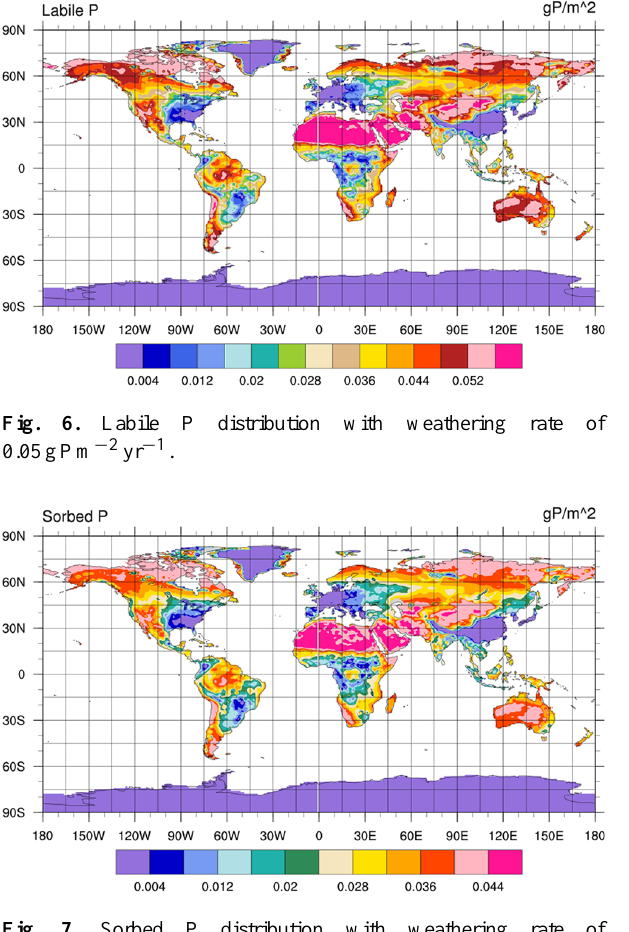
Fig. 7. Sorbed P distribution with weathering rate of 0.05gPm − 2 yr − 1 .